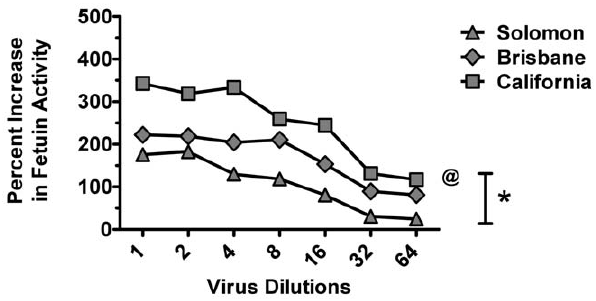
Figure 2. Enzymatic analysis of the NA activity between recombinant viruses. A panel of 7 + 1 rg recombinant viruses was generated by reverse genetics. Each recombinant virus contained the 7 gene segments from the PR8 strain and the NA gene from Solomon, Brisbane, or California. Using a 96-well plate, the activity of each NA in serial two fold dilutions of virus was determined by calculating the percent increase in cleavage of the substrate fetuin between each virus and PBS only wells. Activity was measured at an O.D. of 550 nm. Significant differences in mean activity were seen between rg viruses (* P =0.007). The overall activity of wt California was higher than that of rg Solomon (@P , 0.05) but not rg Brisbane ( P . 0.05). Data is representative of three independent